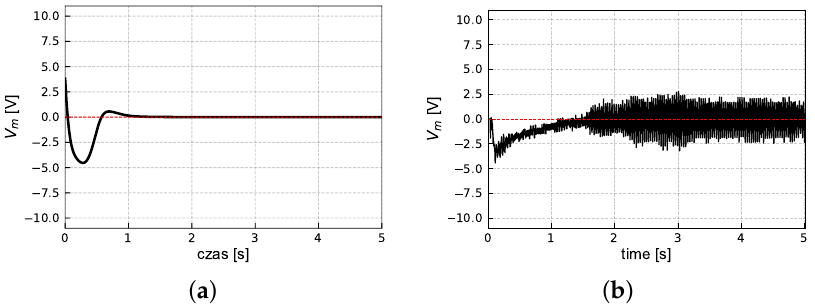
Figure 12. Case B2: Input signal: ( a ) simulation, ( b )